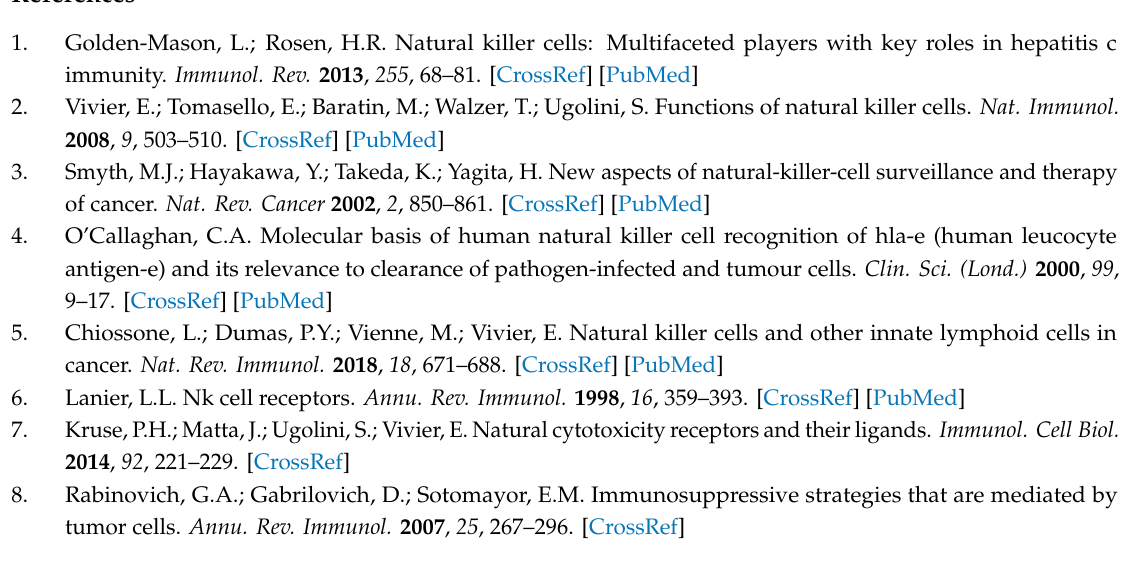
Supplementary Figure S1: E ff ect of PGE2 and TGF- β blockade on restoring NK activity in the co-culture system. Supplementary Figure S2: IDO inhibitor (1MT) partially restores NK cell activity and NK receptor expressions reduced by thyroid cancer. Supplementary Figure S3: Cytolytic activity of NK cells treated with kynurenine against thyroid cancer cells. Supplementary Figure S4: Western blot analysis of the activation of other signals related to NK activity. Supplementary Figure S5: Kynurenine inhibits STAT signals in NK cell through AhR. Supplementary Figure S6: Receptors of NK cells promoter